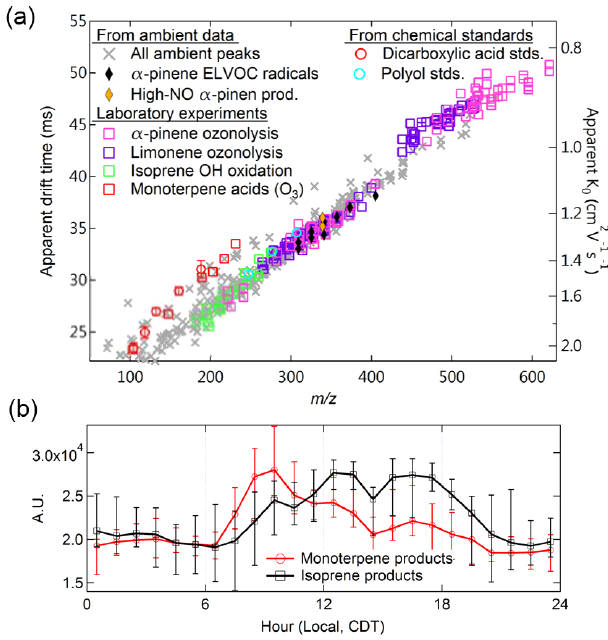
Figure 6. (a) 2-D plot showing an 8h average of SOAS NO 3 -IMS– MS spectra acquired at the CTR supersite. Data from laboratory measurements of chemical standards and BVOC oxidation studies are plotted on top of the ambient data. Monoterpene and isoprene products were generated in a PAM oxidation flow reactor by oxi- dation with O 3 and OH and analytical standards were sublimated before ionization. (b) Diurnal cycles for the sum of the monoter- pene and isoprene peaks highlighted in (a) over a 2-week period during the SOAS campaign. Dicarboxylic acid standards comprised C 3 , C 4 , C 5 , C 7 , and C 9 dicarboxylic acids and polyol standards included threitol, xylitol, and